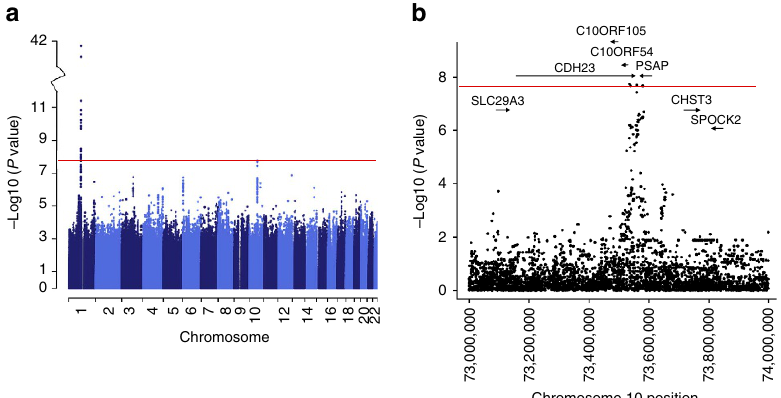
Figure 1 | WGS P values for the association with PGRN levels. ( a ) Manhattan plot depicting the association results by chromosome in which the (cid:3) log10 of the P values are depicted for each genotyped SNP. ( b ) Regional association data for SNPs located on chromosome 10q21.1–22.2 in which arrows depict the location and directionality of genes within the region. Red horizontal lines indicate the genome-wide significance threshold of P ¼ 2.7 (cid:2) 10 (cid:3) 8